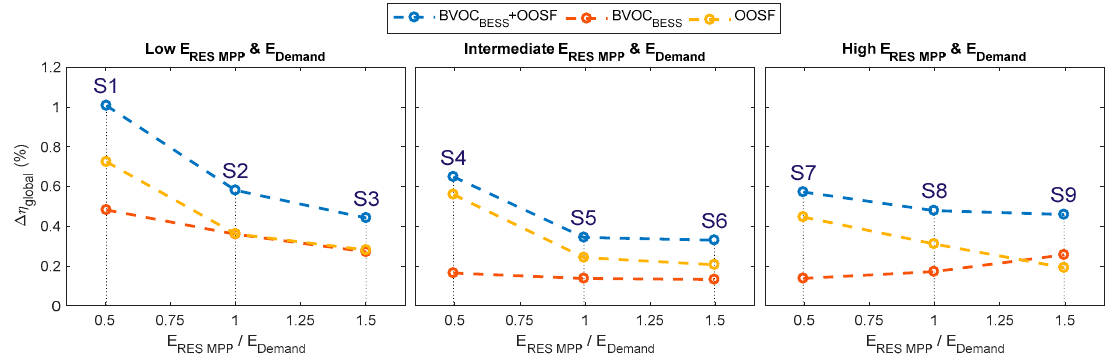
Figure 6. Energy efficiency improvement achieved by simultaneous BVOC BESS + OOSF optimization strategies, only BVOC BESS , and only OOSF in different scenarios.